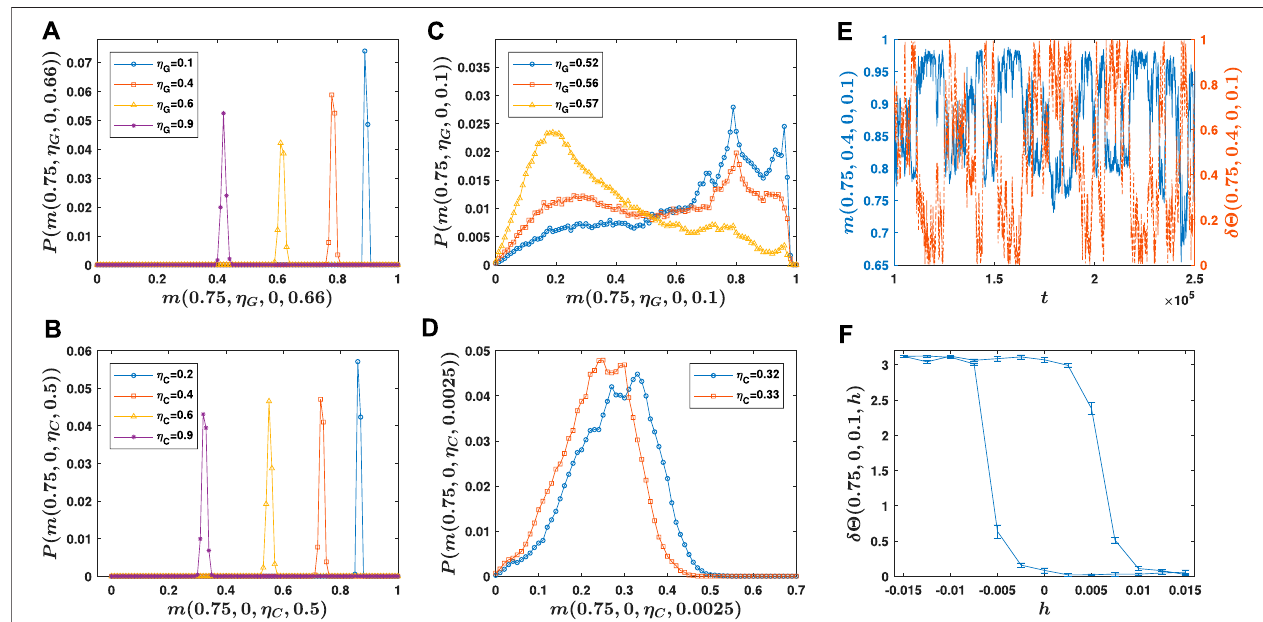
FIGURE 3 | Phase transitions. (A) and (B) : The probability distribution of the order parameter as a function of the order parameter for large fraction of informed individuals, h ,isplotted.Forlarge h ,theorderparameterdecreasegraduallyasnoiseincommunicationincreases,forbothproduction (A) andcomprehension (B) noise. Here L (cid:2) 300, v 0 (cid:2) 0 . 6, and ρ (cid:2) 0 . 1. (C) and (D) : The probability distribution of the order parameter as a function of the order parameter for small fraction of informed individuals, h , is plotted. For small h , where misinformed collective motion is possible, the order-disorder transition is discontinuous for both production (C) and comprehension (D) noise.In (C) L (cid:2) 100, v 0 (cid:2) 0 . 6,and ρ (cid:2) 0 . 1andin(d) L (cid:2) 200, v 0 (cid:2) 0 . 1,and ρ (cid:2) 0 . 1.(e): m ( 0 . 75 , 0 . 4 , 0 , 0 . 1 ) (bluesolidlines)and δ Θ ( 0 . 75 , 0 . 4 , 0 , 0 . 1 ) (red dashed line) as a function of time. With production noise the population is decomposed into several dense independently moving groups. The evolution shows intermittency between the informed collective motion, where different groups move towards the environmental direction (high m low δ Θ ) and misinformed collective motion where different groups head towards different directions (low m high δ Θ ). Here, L (cid:2) 100, v 0 (cid:2) 0 . 6, and ρ (cid:2) 0 . 1. (F) : Hysteresis loop shows the informed- misinformed collective motion transition is of fi rst order. Here, L (cid:2) 20, v 0 (cid:2) 0 . 1, and ρ (cid:2) 1. In all the simulations ω (cid:2) 0 . 25 and η R (cid:2) 0 . 75. ε taken equal to π / 2.